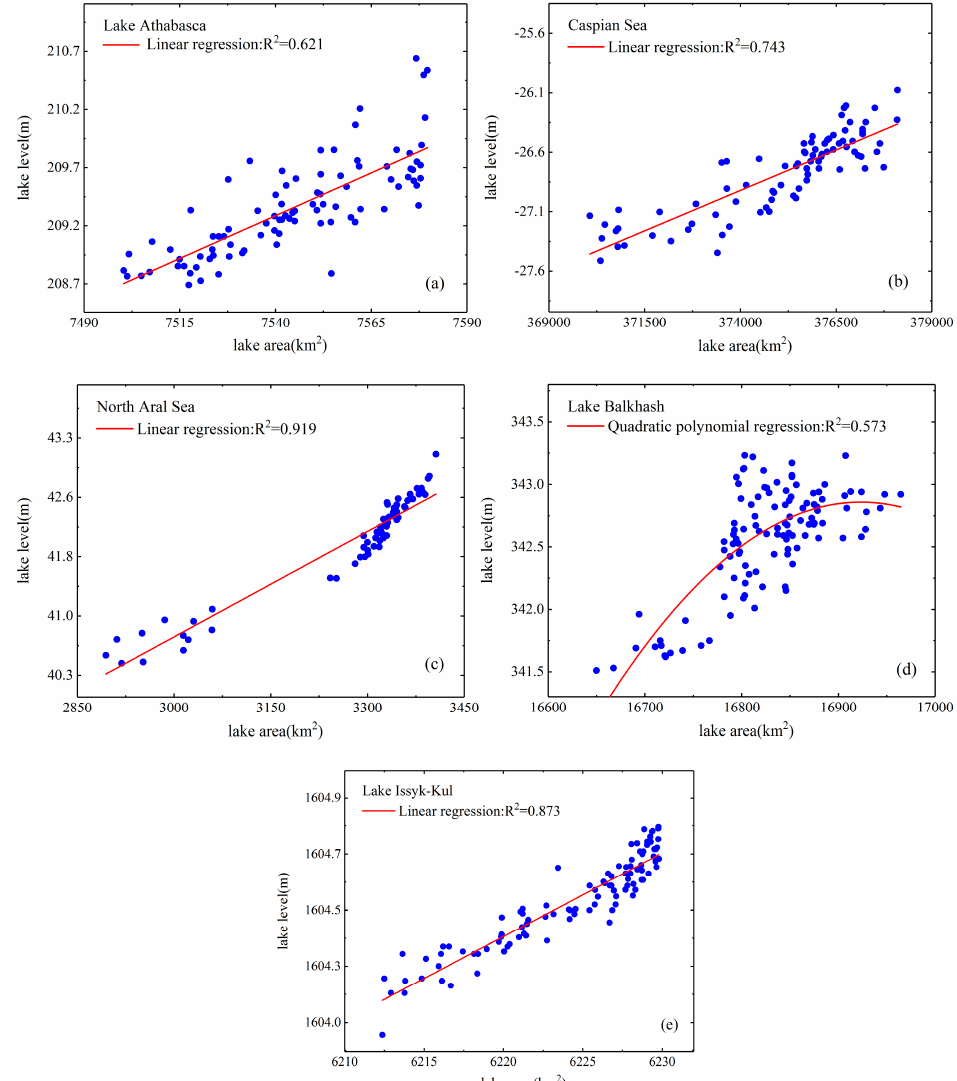
Figure 3. Area and water level regressions for Lake Athabasca ( a ), Caspian Sea ( b ), North Aral Sea ( c ), Lake Balkhash ( d ) and Lake Issyk-Kul ( e ), with R 2 values of 0.621, 0.743, 0.919, 0.573 and 0.873 respectively.